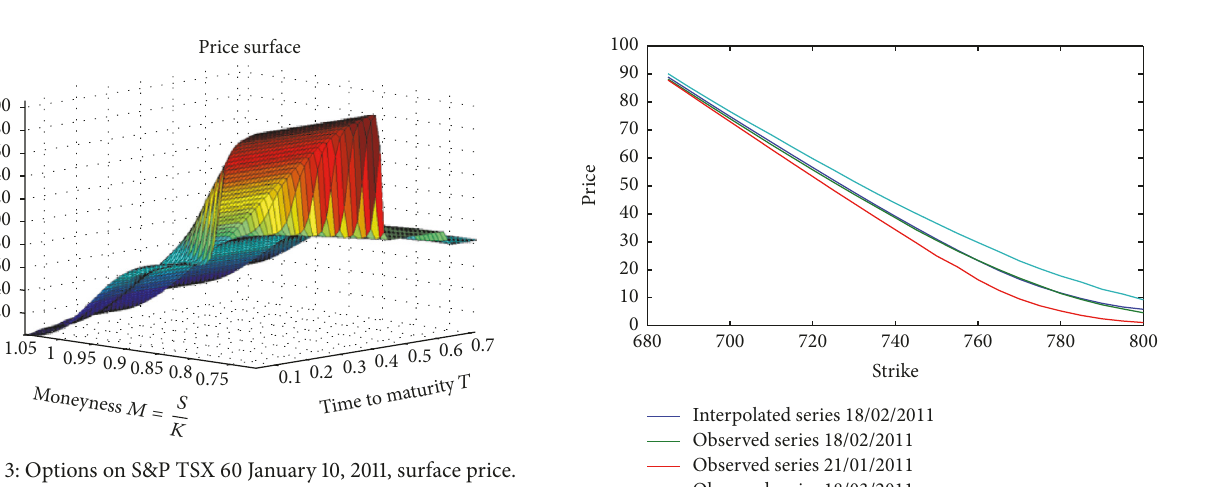
Figure 3: Options on S&P TSX 60 January 10, 2011, surface price.